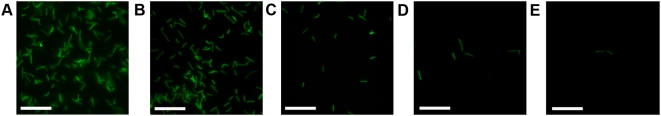
Sensitivity of Fluoromycobacteriophages.Varying numbers of M. smegmatis mc2155 cells were infected with pHAE87::hsp60-EGFP at a moi of 100. After infection at 37°C for 4 hrs, cells were concentrated by filtration and visualize using by fluorescence microscopy. A, 106; B,105; C, 104; D, 103 and E, 102 cells. Scale bar, 20 µm.